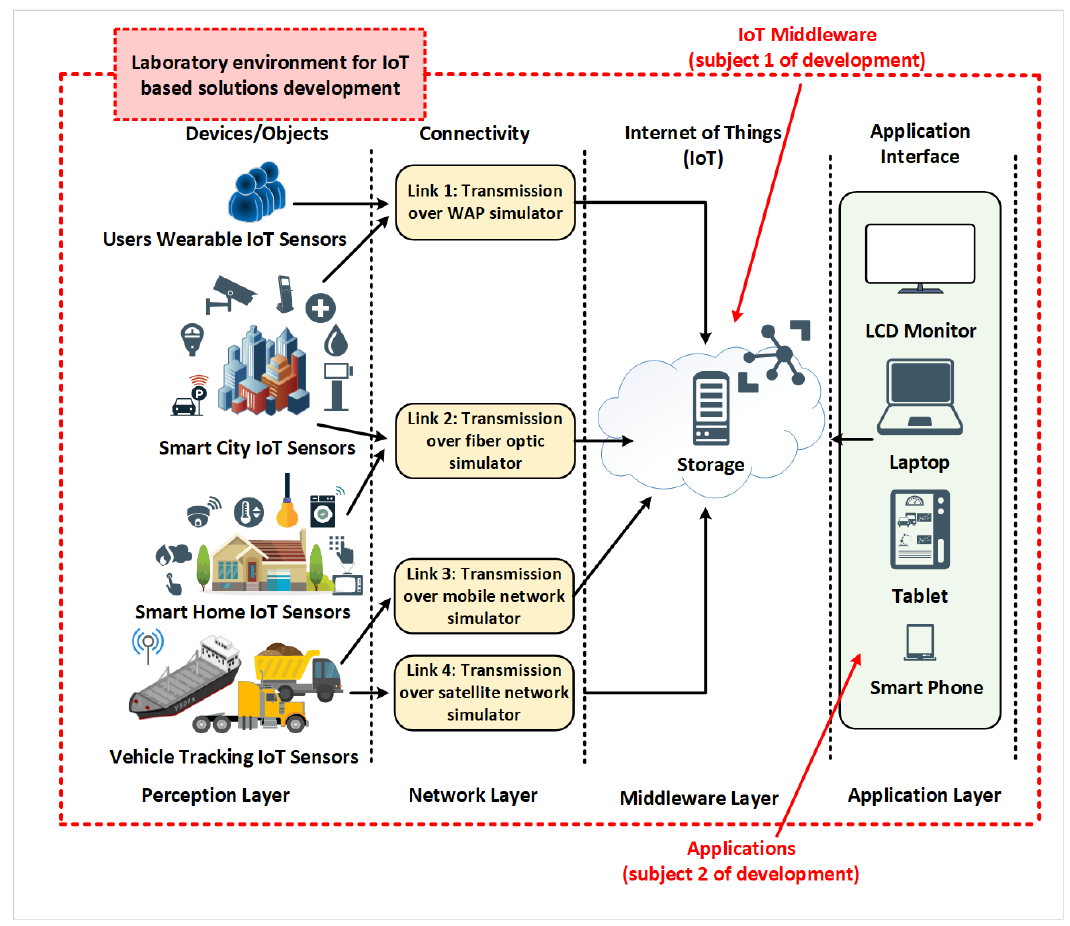
Figure 14. Application in IoT solutions development laboratory.